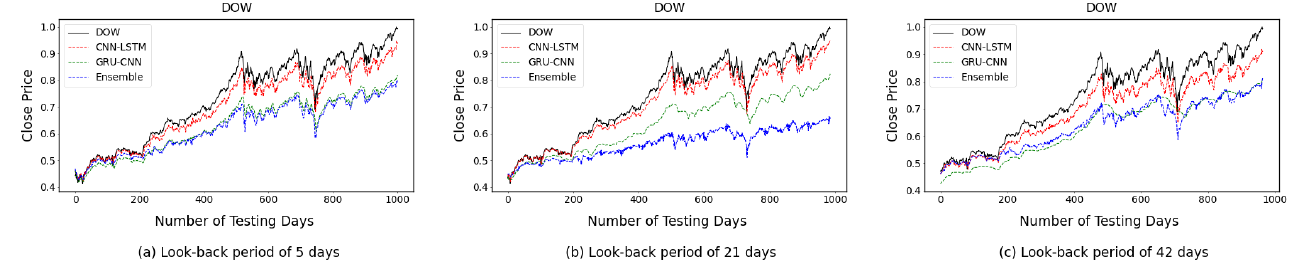
Figure 4. Comparison of true and predicted close prices of the DOW index between different look-back periods for one-time-step prediction over the period from 1 January 2000 through 31 December